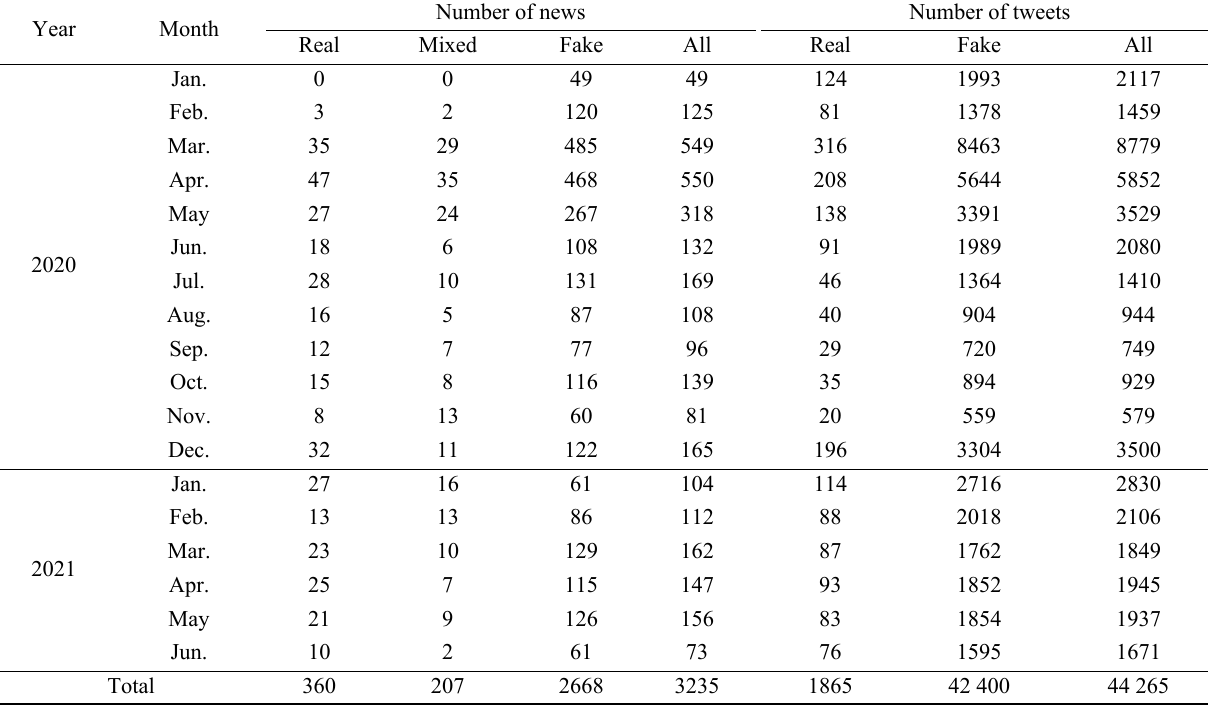
Table 3 Numbers of various types of news and tweets per month considered in this